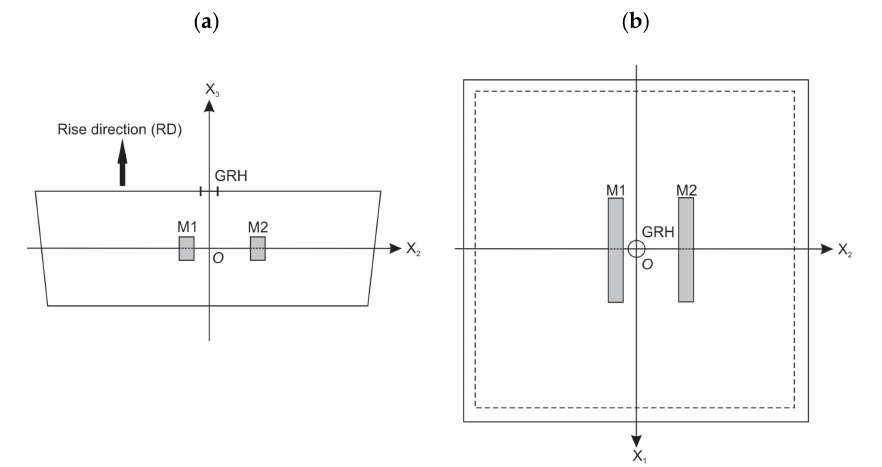
Figure 2. Microscopy samples, M1 and M2, from a PU foams’ block: ( a ) cross-sectional view (Plane X 2 OX 3 ) and ( b ) top view (Plane X 1 OX 2 ); GRH, the gas-release